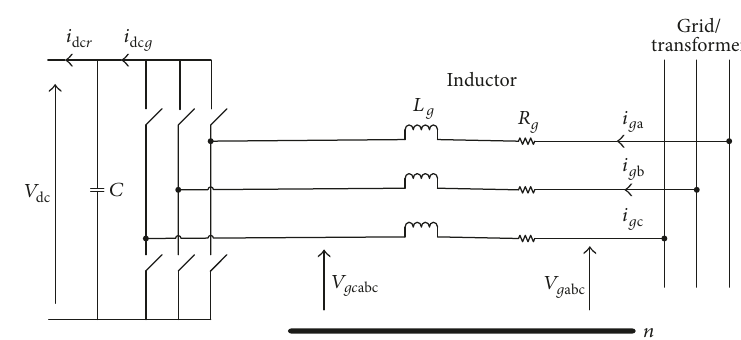
Figure 7: Schematic of GSC connection to grid